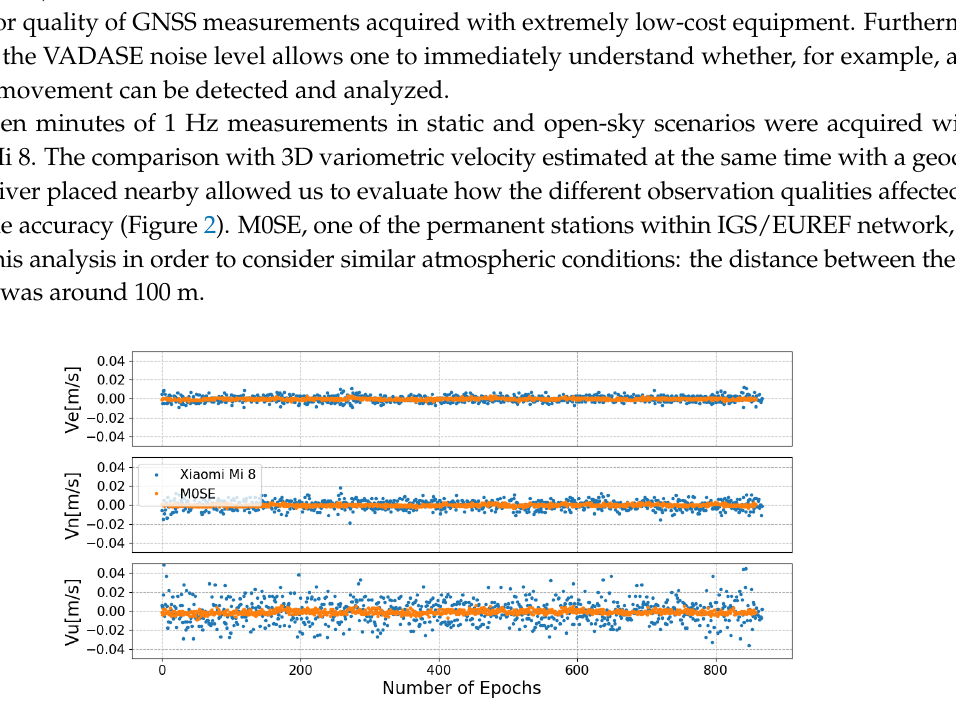
Figure 2. Differences between 1 Hz VADASE (Variometric Approach for Displacements Analysis Stand-alone Engine) solutions from M0SE (orange) and Xiaomi Mi 8